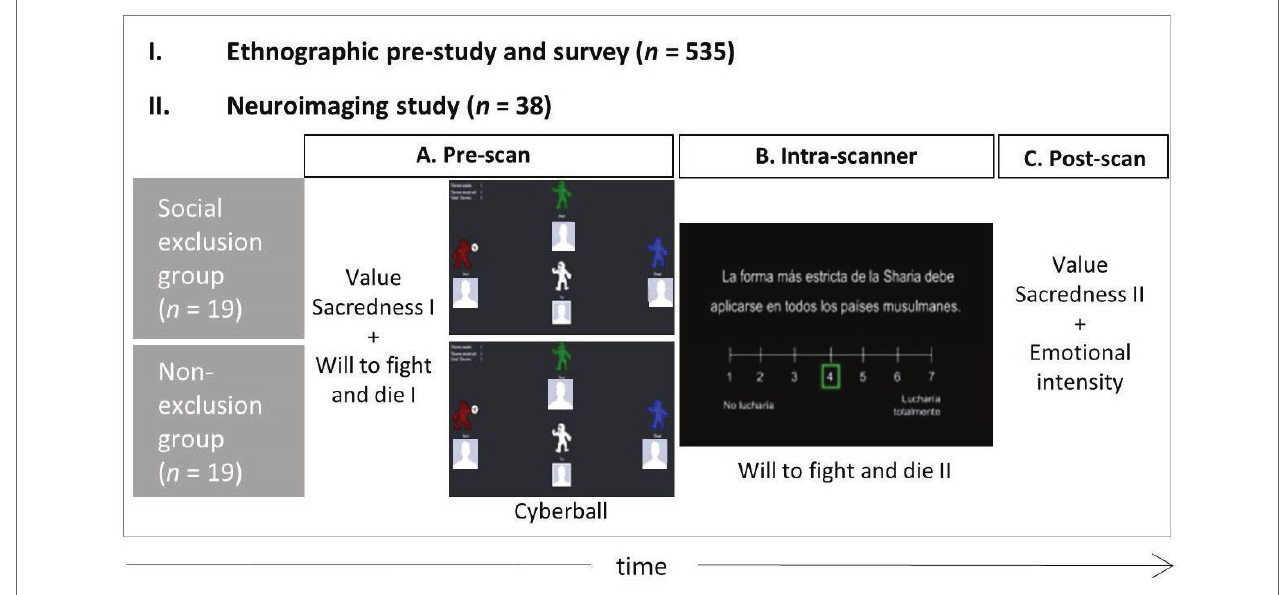
FIGURE 1 | Scheme of the testing timeline consisting of (I) the ethnographic prestudy and survey and (II) the neuroimaging study including (A) a prescan behavioral testing session (around 45 min) including sacred value selection by rejection of material tradeoff, the premanipulation will to fight and die measure for sacred and nonsacred values, and the Cyberball experimental manipulation in either the social exclusion or the non-exclusion condition (between-subjects factor), (B) an intrascanner session (around 20 min) including a postmanipulation will to fight and die measure for sacred and nonsacred values, and (C) a postscan behavioral session (around 45 min) including sacredness reassessment of nonsacred values by rejection of material trade-off and emotional intensity scores at the thought of defending each